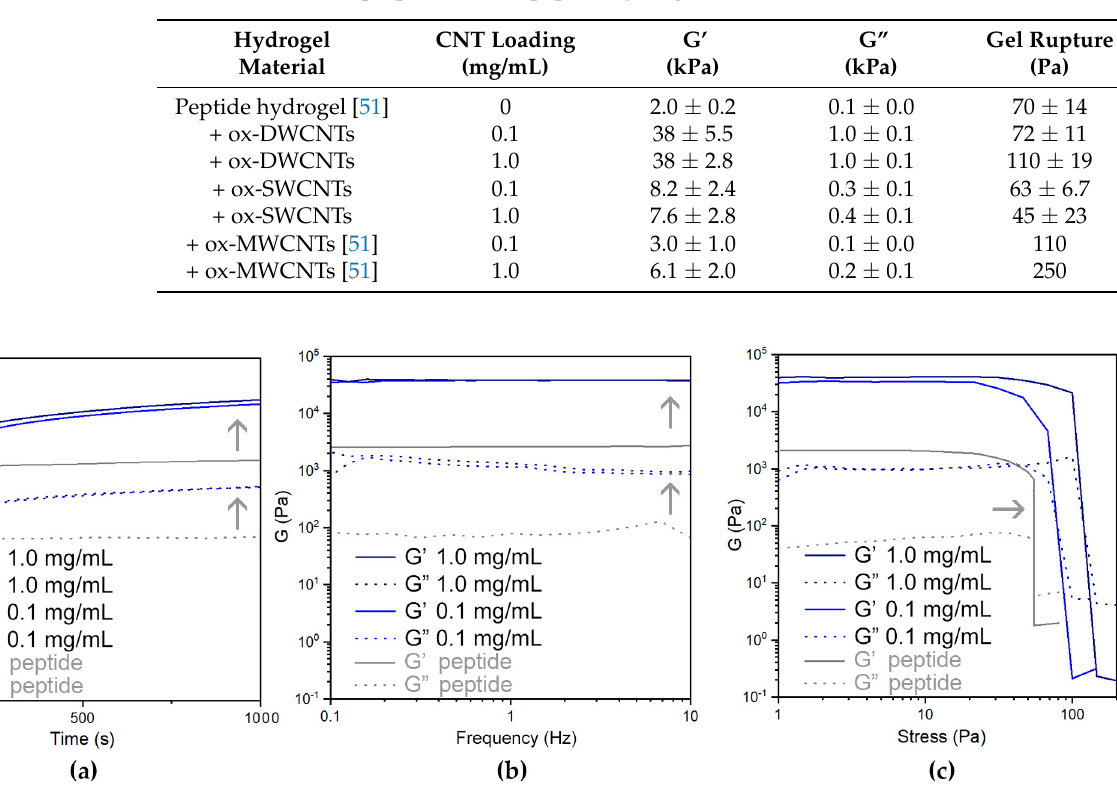
Figure 7. Oscillation-based rheometry of peptide hydrogels without (grey) or with (blue) ox-DWCNTs: ( a ) kinetics; ( b ) frequency ramps; ( c ) stress ramps. Grey arrows indicate ox-DWCNTs’ effects on the viscoelastic properties of the peptide gels.